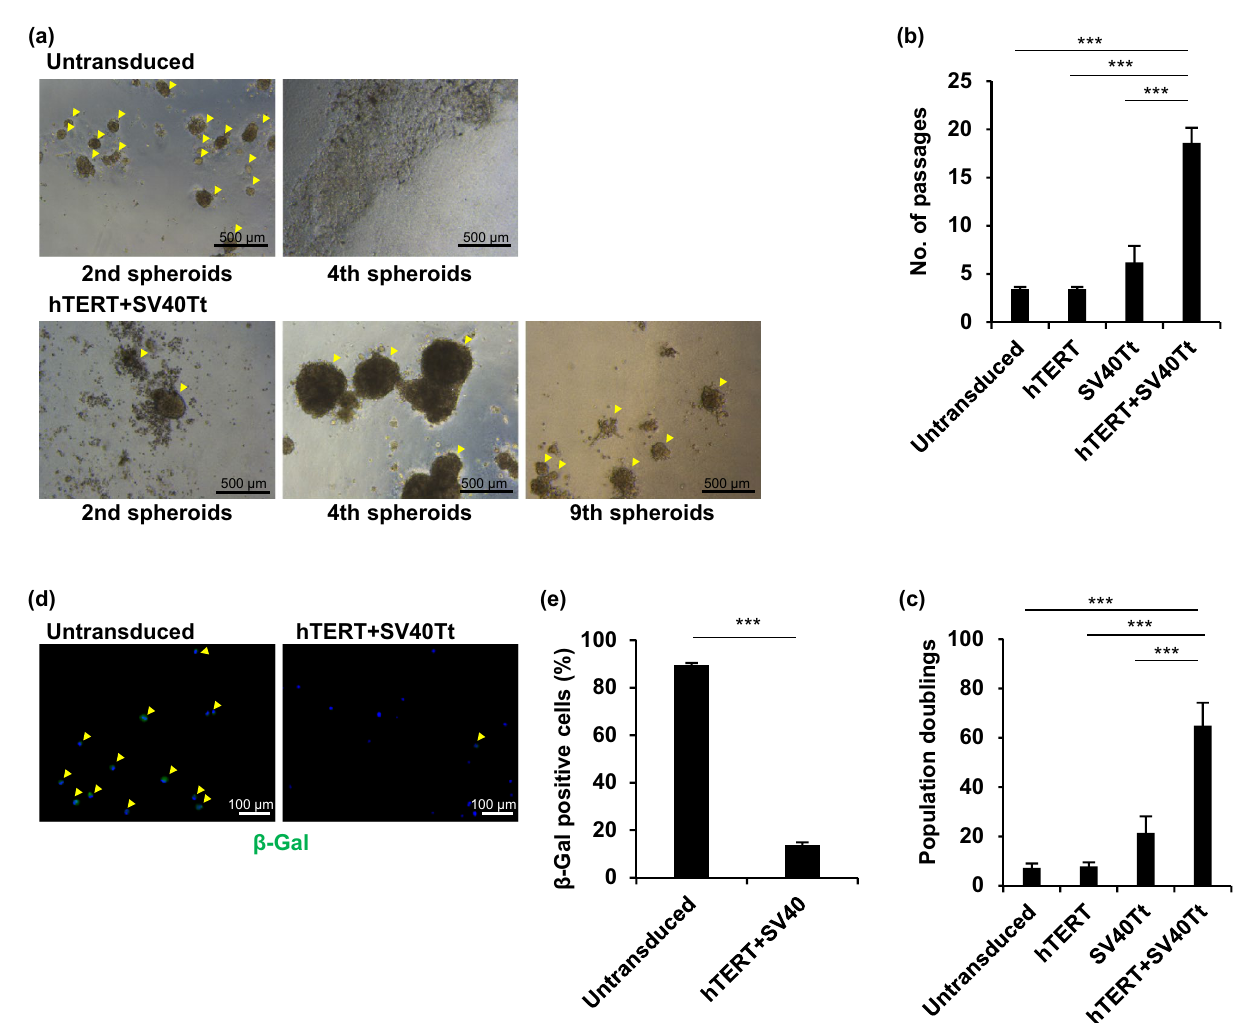
Figure 2. Establishment of immortalized sweat gland cells in spheroid culture. ( a ) Spheroids formed from sweat gland cells transduced with human telomerase reverse transcriptase (hTERT) and Simian Virus 40 large T and small t antigen (SV40Tt) genes at the indicated generation of spheroids. The cells were passaged once daily for seven days. Arrowheads indicate spheroids. ( b , c ) Number of passages ( b ) and population doublings ( c ) in spheroid culture of sweat gland cells transduced with hTERT and/or SV40Tt genes. Data are presented as the mean ± standard error (S.E.) of five independent experiments (n = 5). ***P < 0.001. ( d ) β-galactosidase (β-gal) staining of sweat gland cells transduced with hTERT + SV40Tt and untransduced cells at the 4th spheroid. Arrowheads indicate β-gal-positive cells. Nuclei were stained with 4 ′ ,6-diamidino-2-phenylindole (DAPI). ( e ) Rate of β-gal-positive cells in hTERT + SV40Tt transduced cells and untransduced cells. At least 50 cells were counted under each condition. Data are presented as the mean ± S.E. of five independent experiments (n = 5). ***P < 0.001. Scale bars: 500 μm in A and 100 μm in